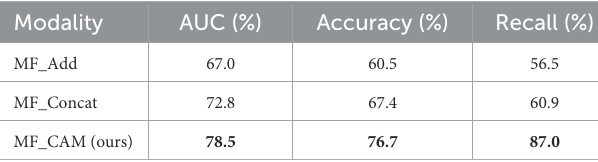
TABLE 3 Comparison of classification performance based on different modalities.